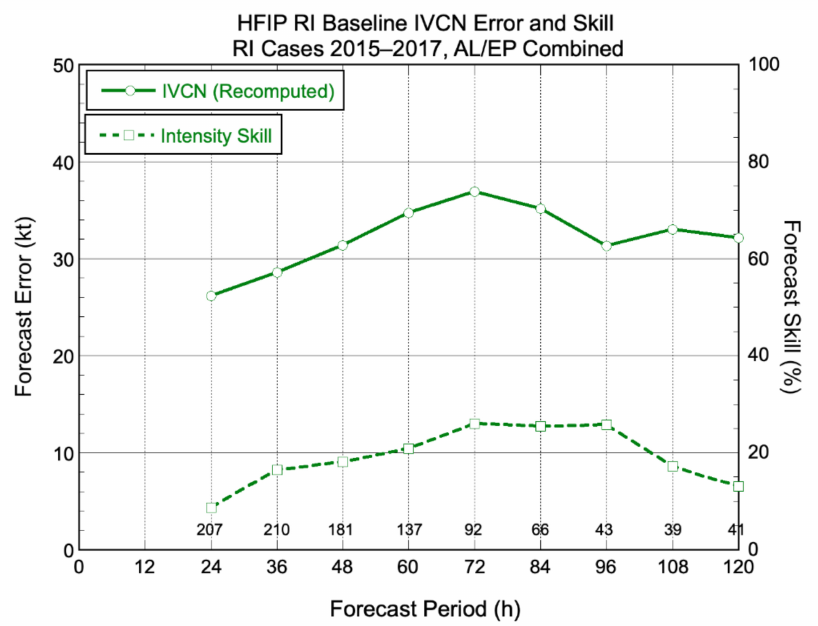
Figure 12. HFIP RI performance measure baseline errors and skill. Baseline errors are the mean absolute errors over the period 2015–2017 for the Atlantic and eastern North Pacific for IVCN, the variable consensus comprising at least two of the models DSHP, LGEM, GHMI, HWFI, and CTCI. Skill values are computed relative to the climatology and persistence model OCD5.